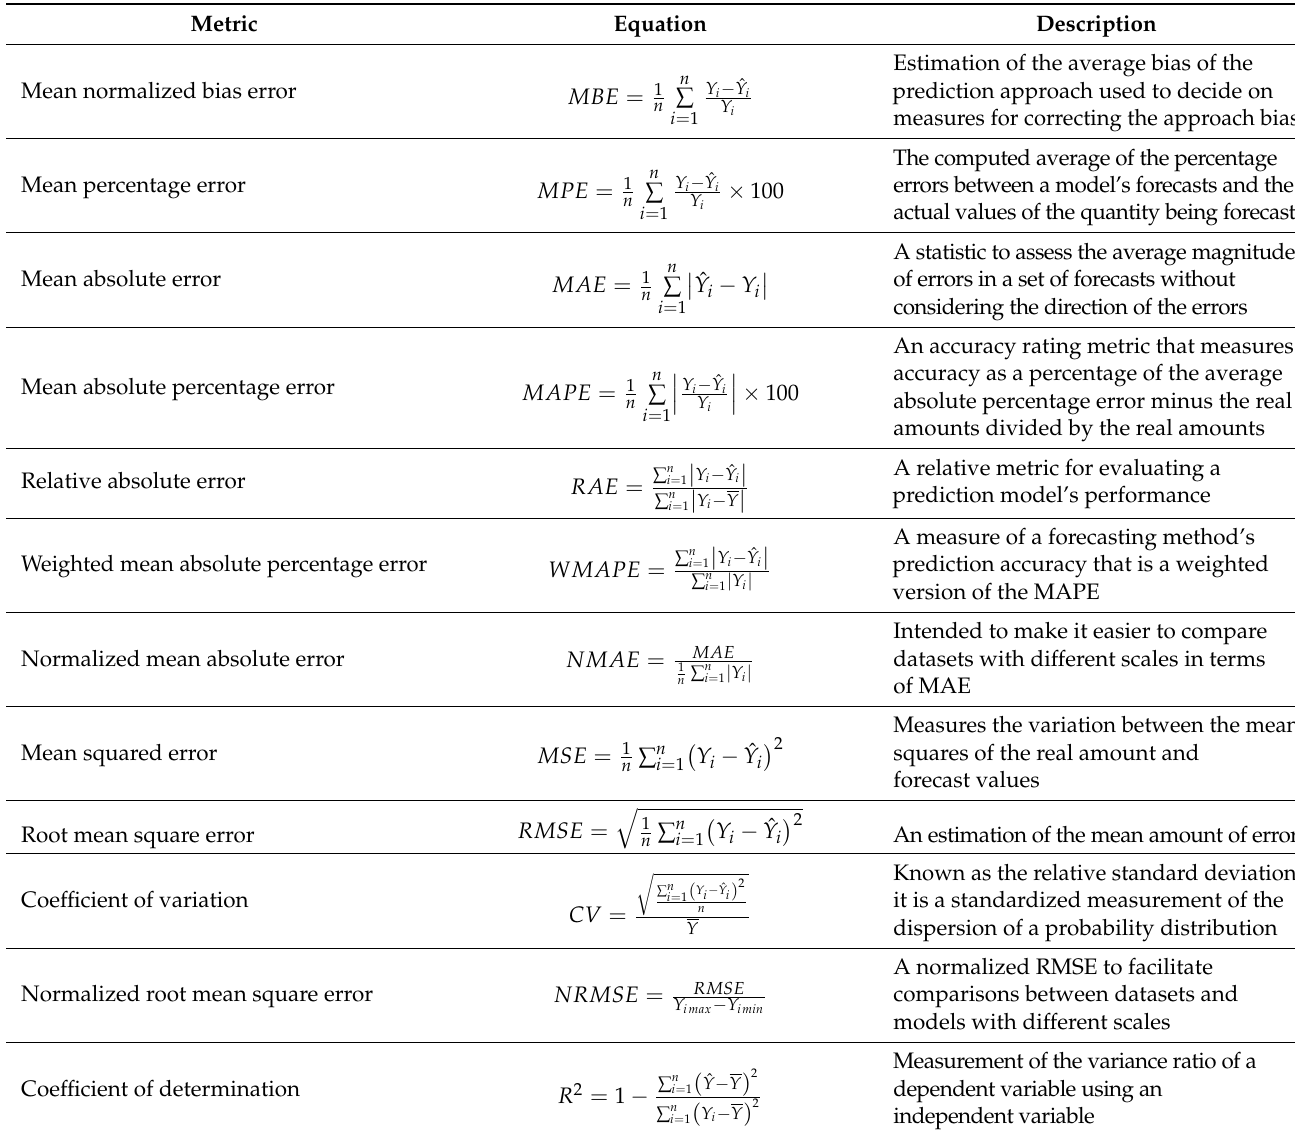
Table 3. Performance criteria for prediction model evaluation